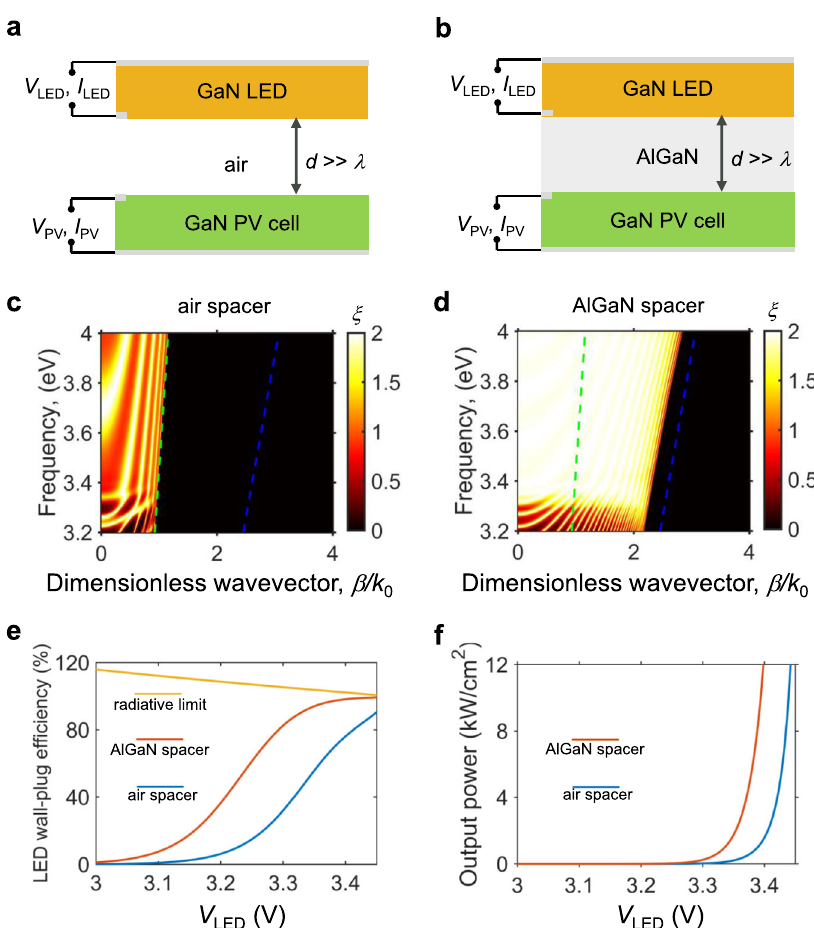
Fig. 3 The impact of the AlGaN layer on optical coupling. a The setup for the far- fi eld case with an air spacer layer having a thickness of d = 1 μ m. b The setup for the AlGaN spacer layer case where the LED and the PV cell are coupled through a thin Al .5 Ga .5 N layer with a thickness of d = 1 μ m. Metallic mirrors (the thick gray lines) are placed on the back of the LED and the PV cell for photon recycling and electrical contact purposes. They are modeled as a perfect conductor in the simulation. The thicknesses of the LED and the PV cell are set to be 1 μ m for both the air and the AlGaN spacer cases. c , d Photon transmission coef fi cients for the cases with air spacer layer and AlGaN spacer layer, respectively. The green dashed line is the light line of the vacuum given by β ¼ ω = c , and the blue dashed line is the light line of GaN given by β ¼ n GaN ω = c , where n GaN ¼ 2 : 65 is the refractive index of GaN near its bandgap. The wavevectors are normalized by the free-space wavevector at the bandgap frequency. e The wall-plug ef fi ciency of the LED in three cases: the radiative limit (i.e., nonradiative recombination rates are zero), the AlGaN spacer case, and the air spacer case. f Output power density of the GaN PV cell in the air spacer and AlGaN spacer cases at the maximum ef fi ciency (power density) operation point. The wall-plug ef fi ciency and the output power density are greatly enhanced in the AlGaN spacer case as compared to the far- fi eld air spacer